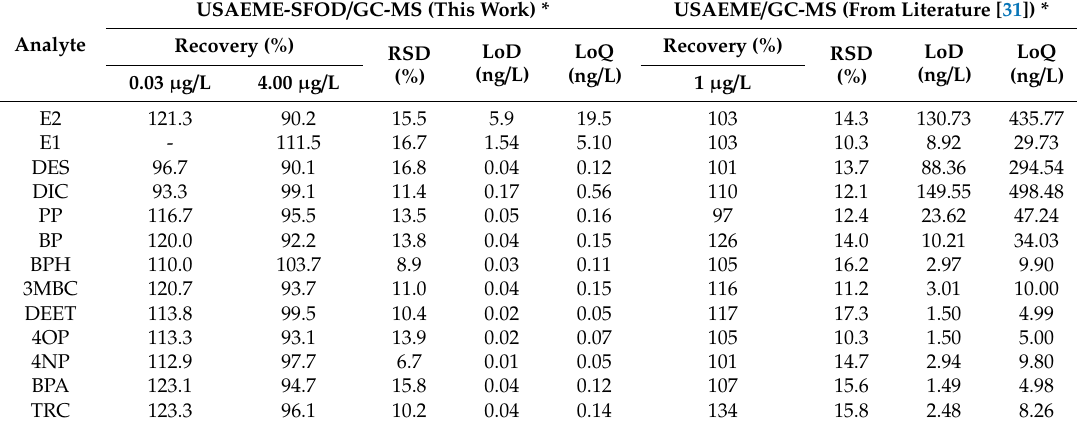
Table 4. Limits of detection and quantification, repeatability, and trueness of the developed method, and its comparison with values obtained when the solvent with a density higher than water (chloroform) is